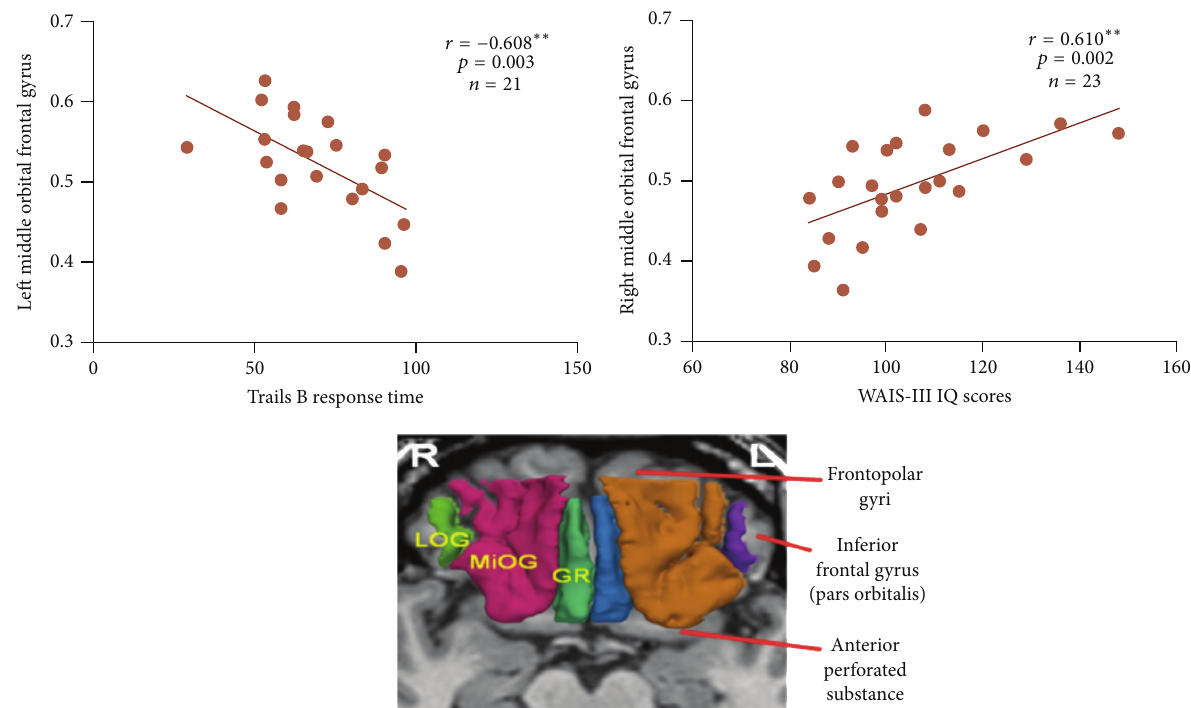
Figure 1: Orbital frontal cortex subregions of the lateral orbital gyrus (LOG), middle orbital gyrus (MiOG), and gyrus rectus (GR) along with scatter plots of right MiOG with WAIS-III full-scale IQ and left MiOG with Trails B response ∗∗ 𝑝 < .01